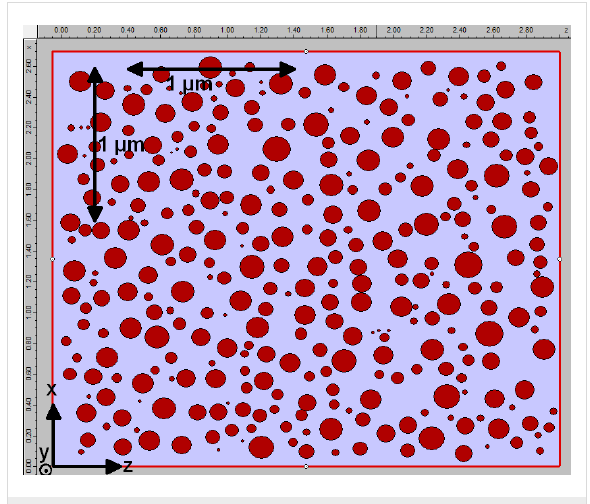
Figure 2: Top view of the simulation setup.